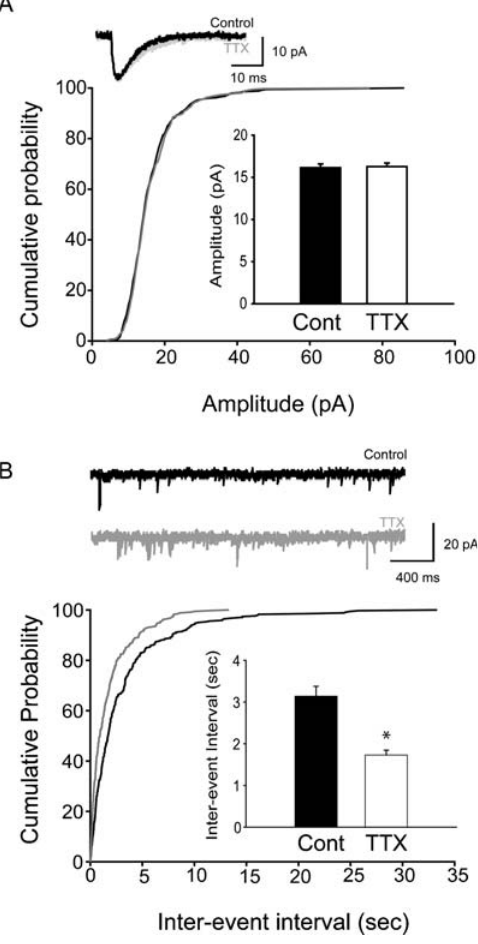
Figure 2. Unchanged amplitude, but increased frequency of mEPSCs in CA1 pyramidal cells from adult animals after in vivo TTX- application. (A) Summary data (from all cells) of the mEPSC amplitudes in TTX-treated and control adult rats are shown in the form of cumulative probability plots (for numbers of events and animals, see main text); the bar graph shows the same data in the form of averages 6 SEM, and the insert displays representative averages of mEPSCs from single cells. (B) Summary data of the inter-event intervals of mEPSCs, with example traces.